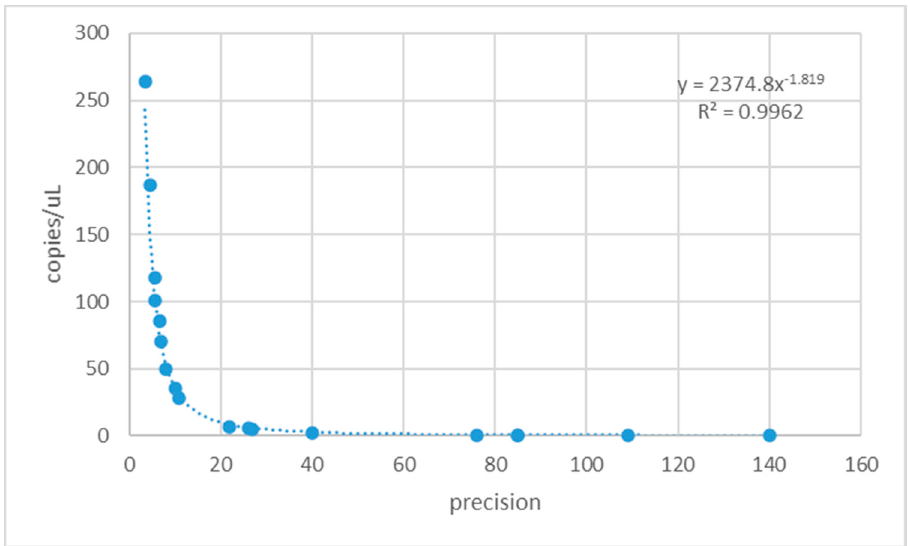
Figure 4. Relationship between precision values and copies / µ L determined with the four Fusarium detection assays.